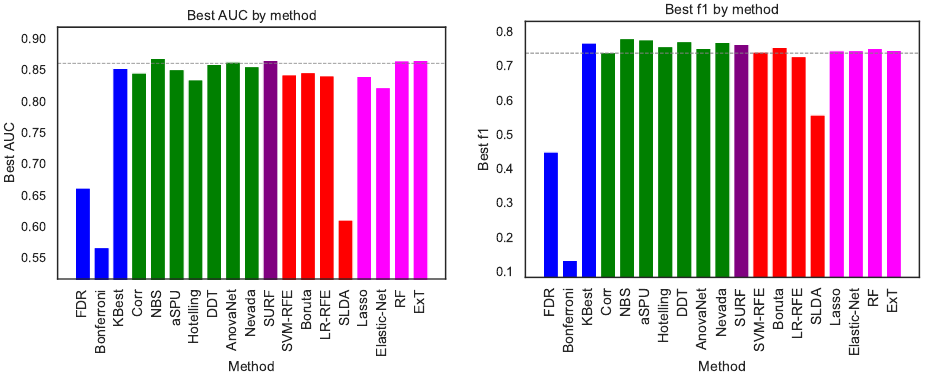
Figure 2. Best classification score, in terms of AUC ( left panel ) and F1 ( right panel ), obtained by the 19 feature selection methods here considered. Bar colours indicate the family of each method, using the same code as in Figure 1. The horizontal dashed line represents the classification score obtained by a RF model on the whole connectivity matrix, i.e., without any link selection.